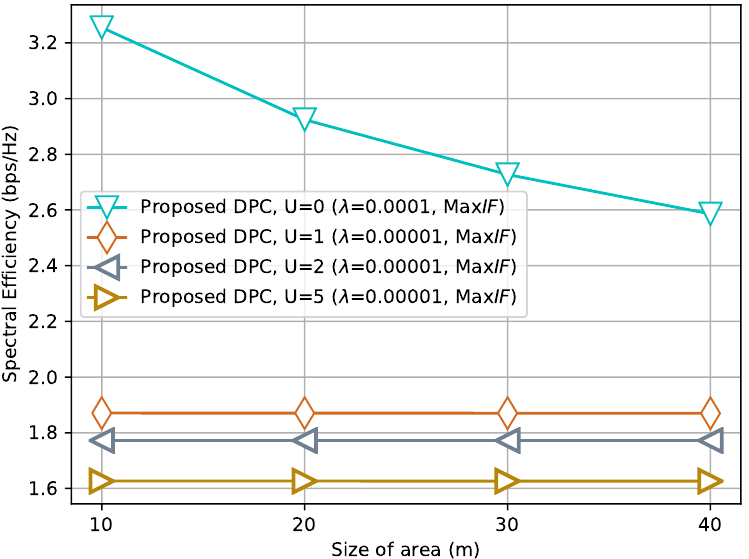
Figure 16. Average spectral efficiency of the proposed scheme for α = 3.8 in Nakagami- m fading channels with m = 3 when the cellular users are out of the D2D communication